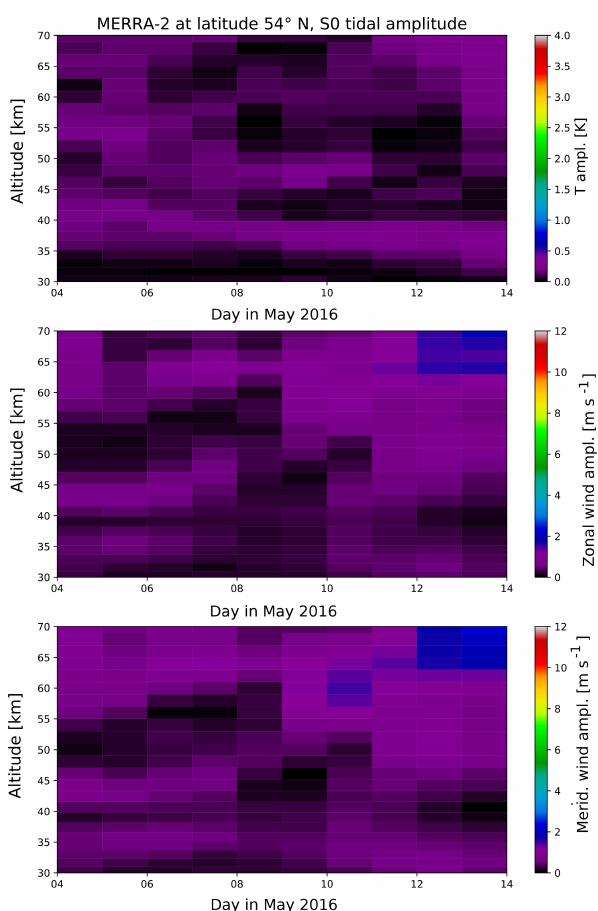
Figure A2. S0 amplitude in temperature, zonal and meridional wind from global MERRA-2 fields at the latitude of 54 ◦